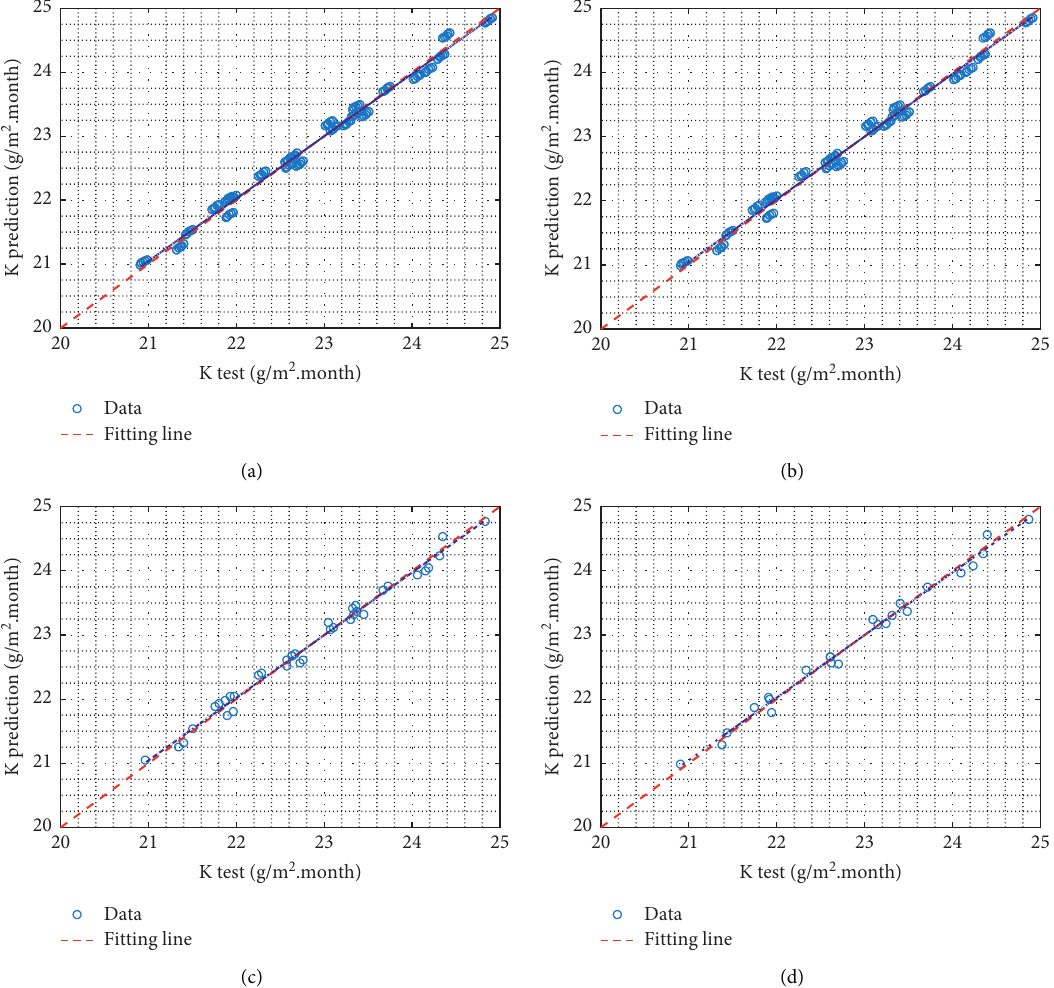
Figure 6: Regression results of the optimal ANN model. (a) All-data: R 2 � 0.9998. (b) Training: R 2 � 0.9998. (c) Validation: R 2 � 0.9998. (d) Testing: R 2 �